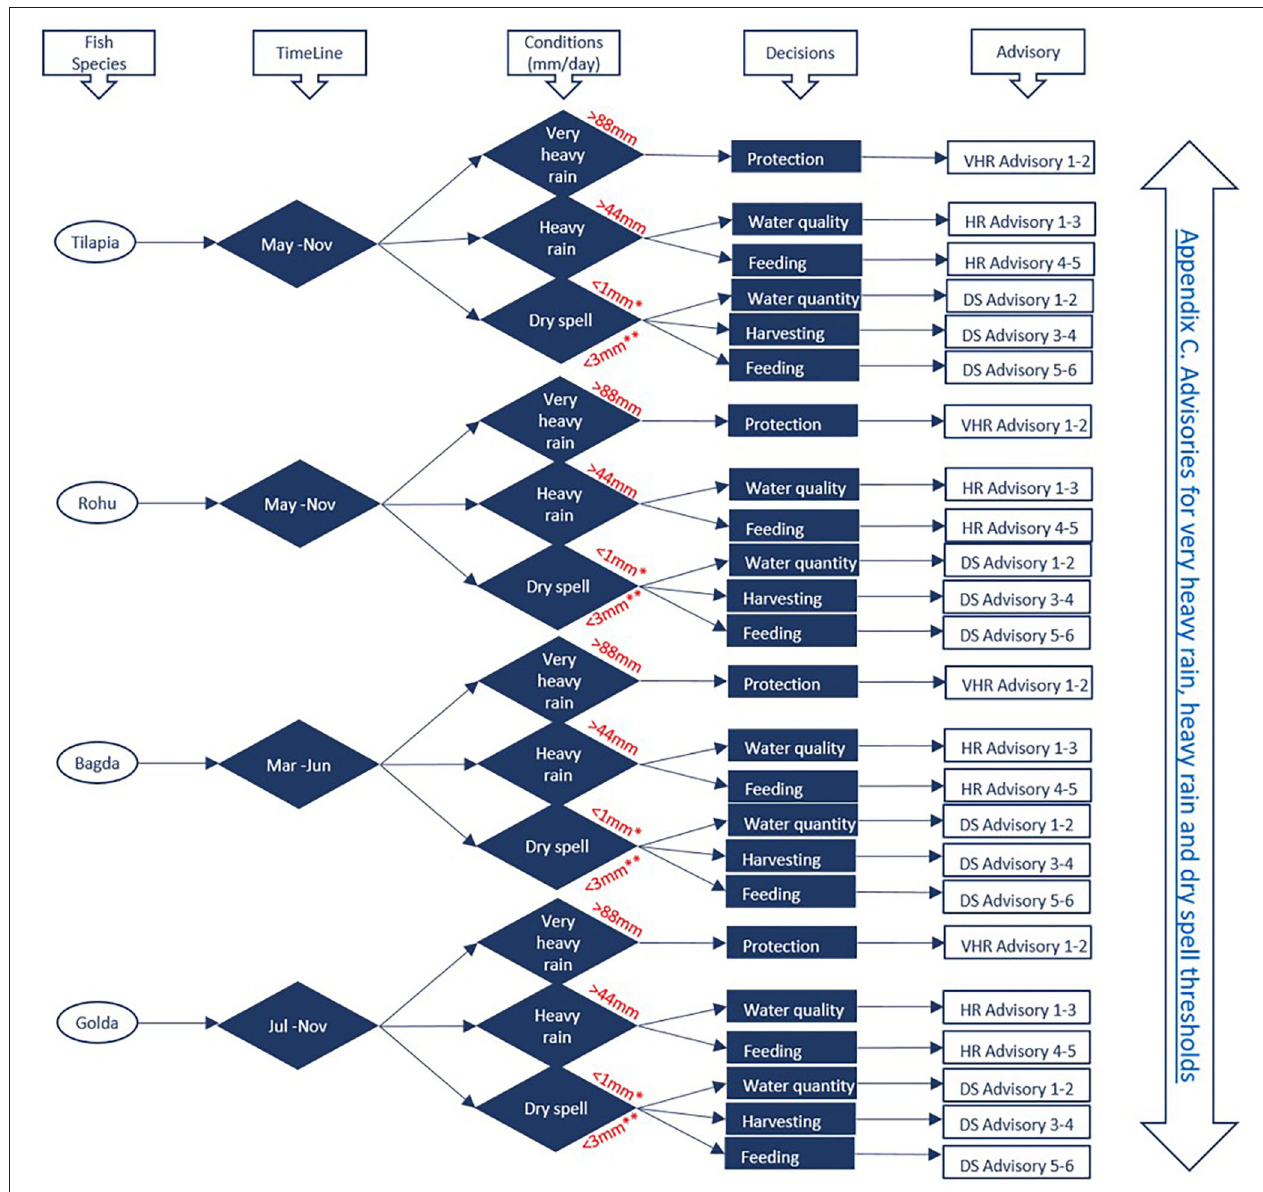
FIGURE 11 | Decision framework based on rainfall thresholds for four widely cultivated aquatic